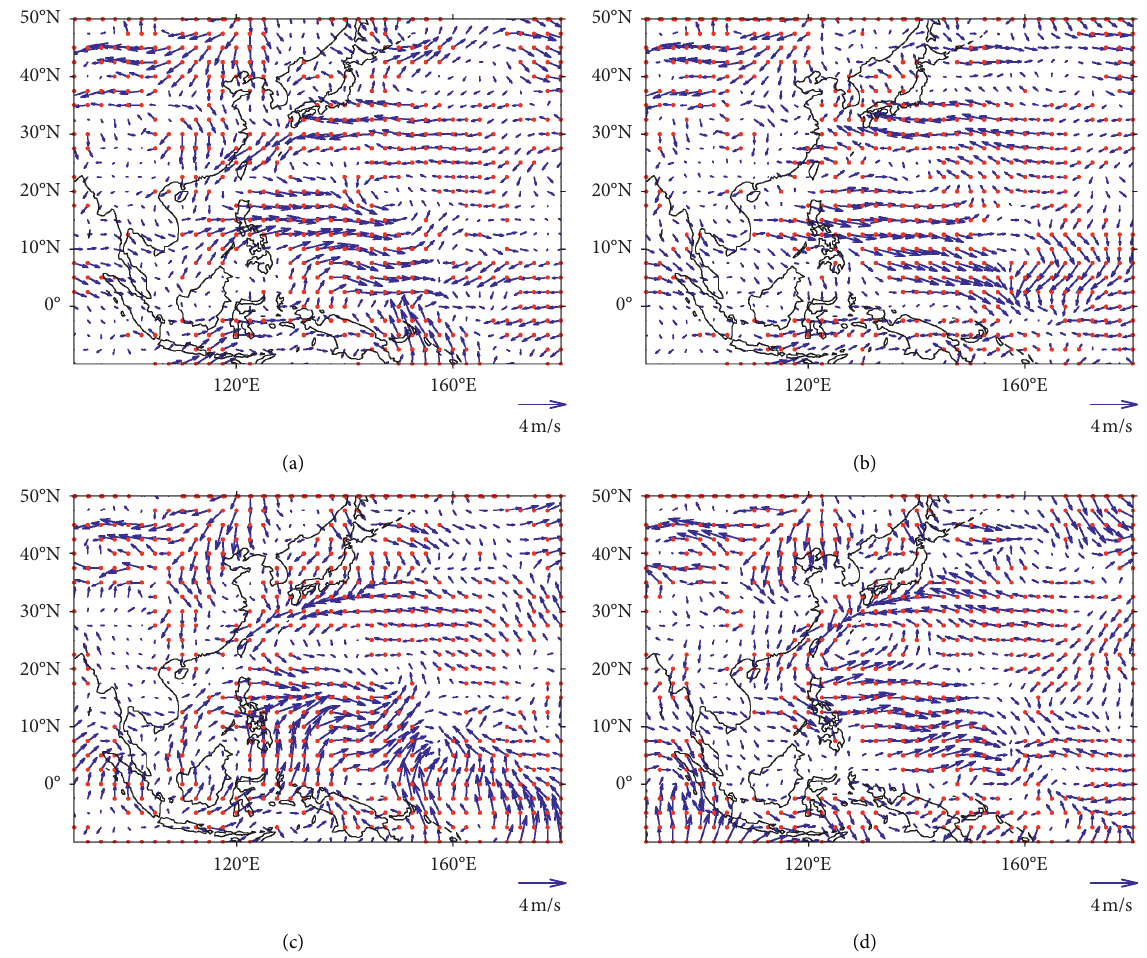
Figure 6: Composite anomalies of the summer (JJA) mean wind (vector, m s-1) for (a) developing CP El Niño and cool PDO years, (b) decaying CP El Niño and cool PDO years, (c) developing CP El Niño and warm PDO years, and (d) decaying CP El Niño and warm PDO years. Signals above the 95% confidence level are highlighted by red